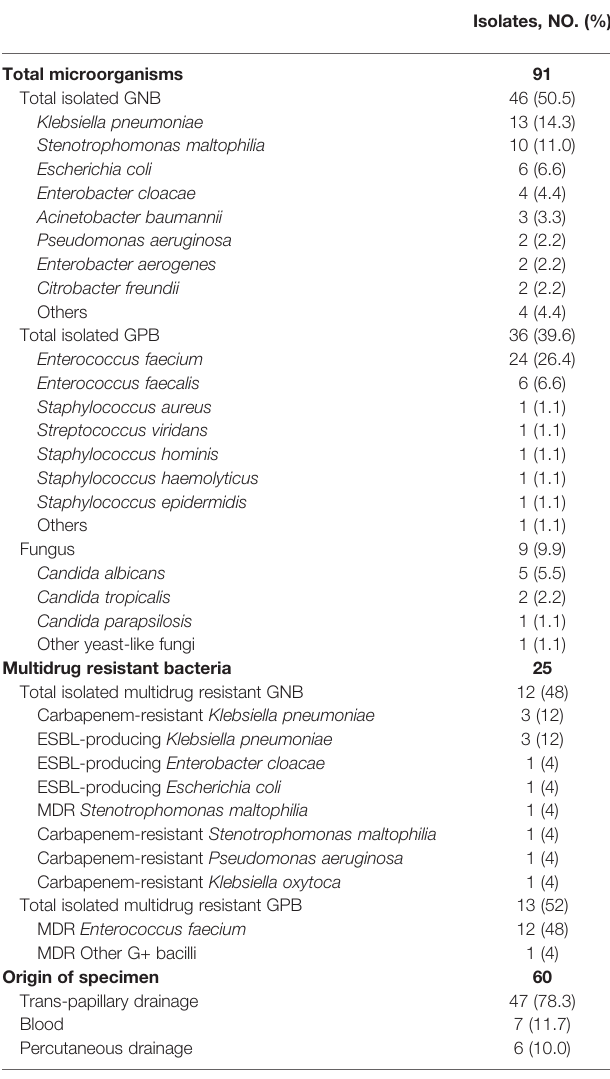
TABLE 4 | Total microorganisms and multidrug resistant microorganisms.